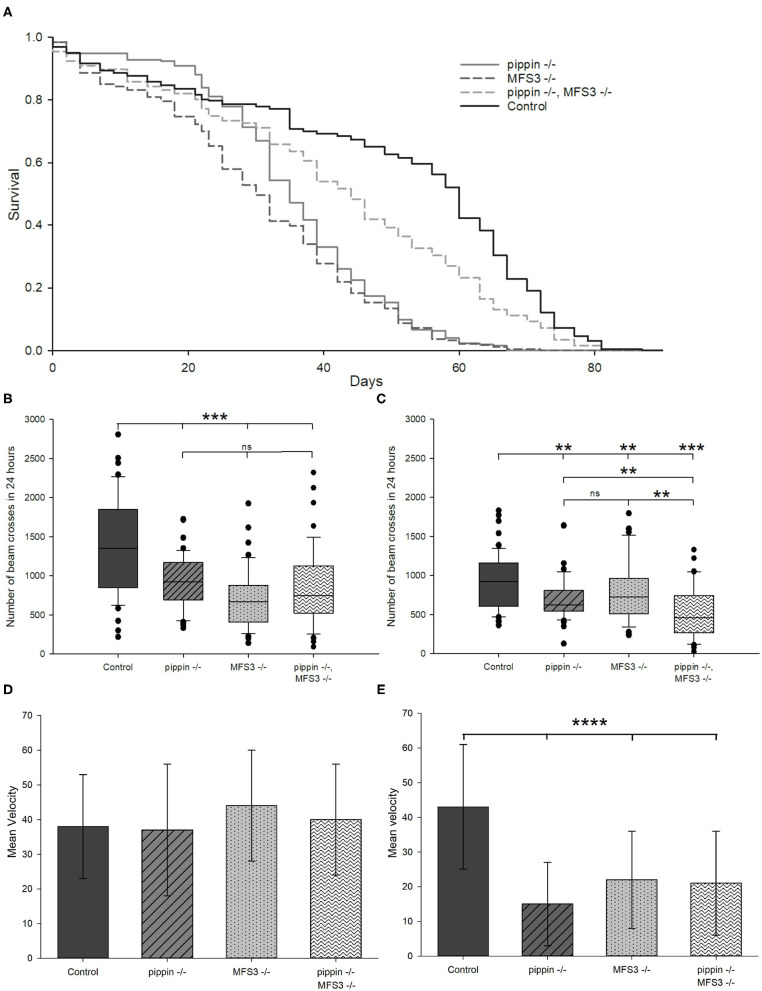
pippin and Mfs3 null mutants are viable, but display shortened lifespan and reduced locomotor activity. (A) Survival curves of null mutants and control animals. All mutants show a reduced lifespan compared to control animals, however double pippin−/−, Mfs3−/− mutants live significantly longer than single mutants. N = 3, n ≥ 180 (pippin−/−: p < 10−21, Mfs3−/−: p < 10−23, pippin−/−, Mfs3−/−: p < 10−4; log-rank test). (B,C) Activity monitored over 24 h of null mutants and control animals at 2 weeks old (B) and 5 weeks (C) of age. All mutants show a reduction in activity compared to control animals at 2 weeks of age, however the double mutants show a progressive reduction in activity moving significantly less than the single mutant at 5 weeks of age. N = 3; n ≥ 58; **p ≤ 0.01, ***p ≤ 0.001. (D,E) Negative geotaxis assay measuring climbing ability as an escape response of 2 (D) and 5 (E) weeks old flies. Single pippin−/− or Mfs3−/− mutants show no reduction in climbing ability at 2 weeks but show a decrease in activity at 5 weeks of age. N = 5; n ≥ 500; ****p ≤ 0.0001.